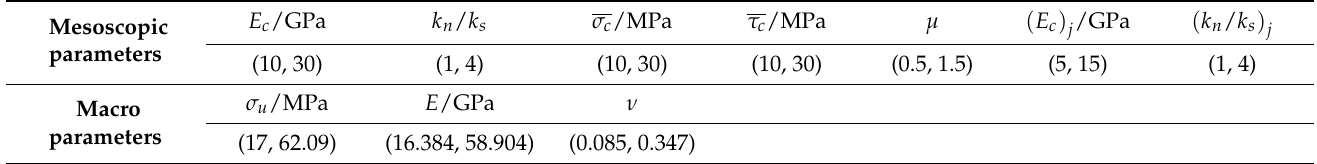
Table 13. Calculation range of the microscopic parameter calibration program.